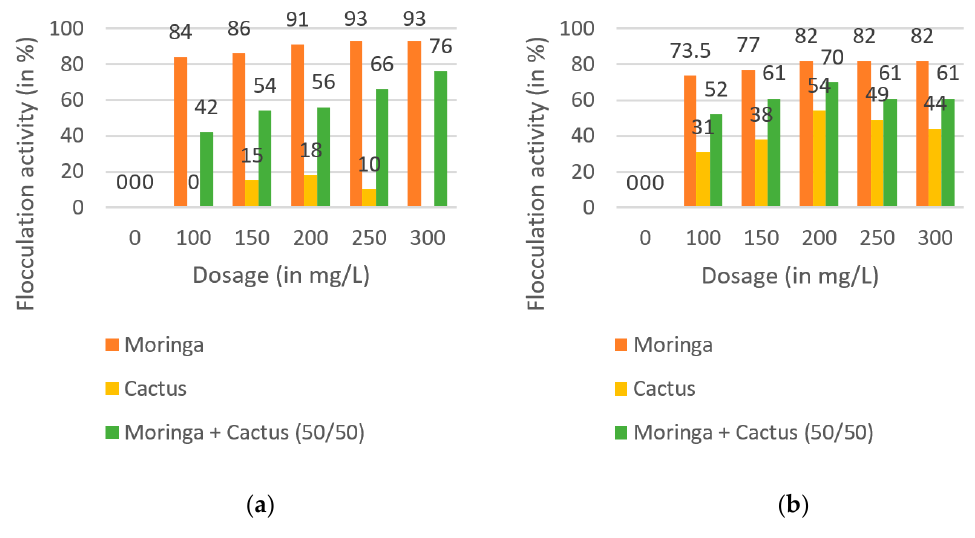
Figure 2. Flocculation activity in model suspension ( a ) and natural surface water ( b ).